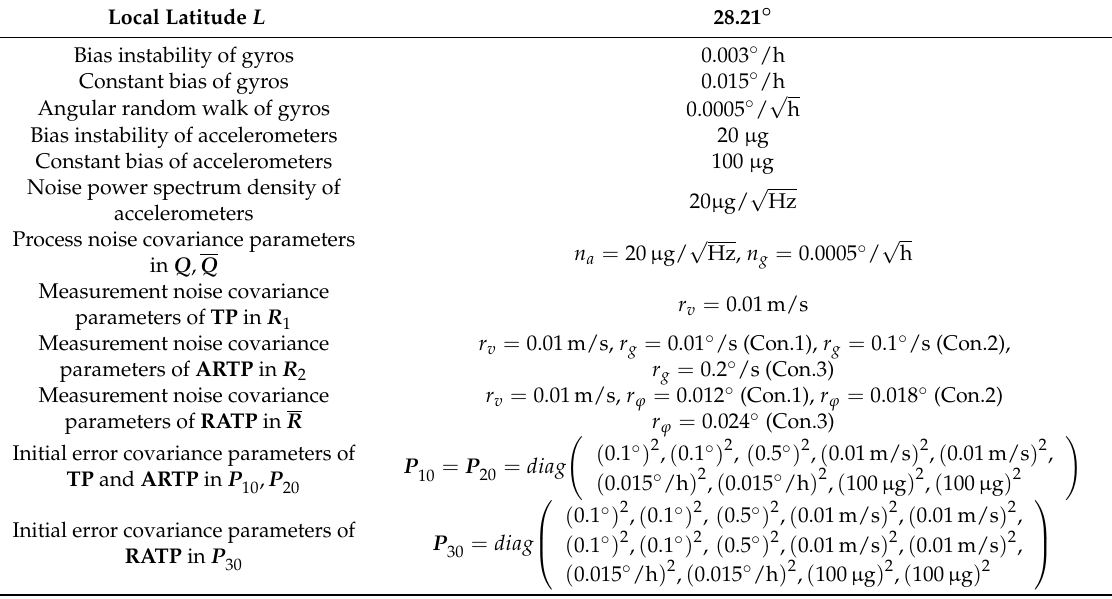
Table 1. Parameters for